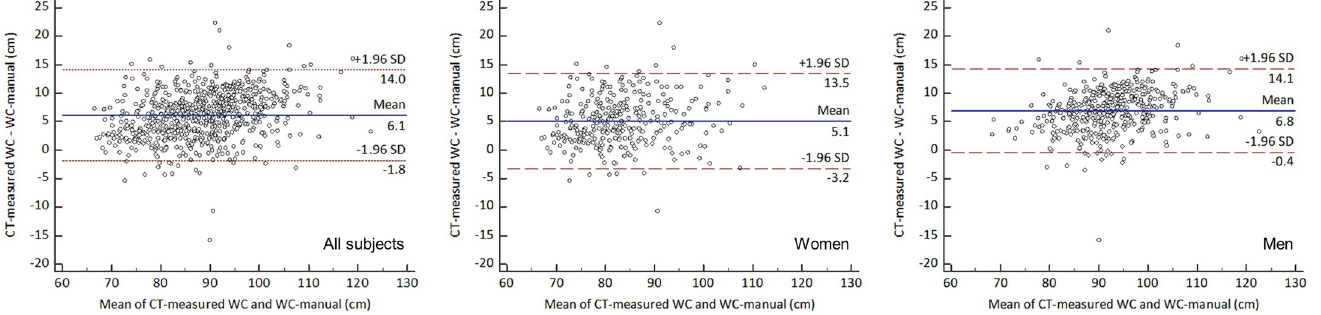
Fig 3. Bland-Altman plot of CT-measured versus manually-measured waist circumferences. WC = waist circumference, SD = standard deviation.